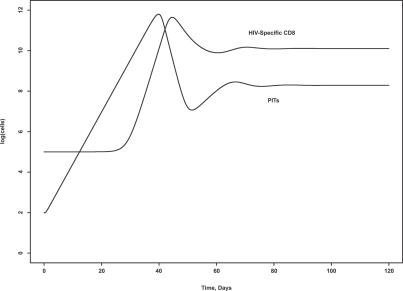
Whole-Body, Deterministic Model Suitable for HIV, Showing Infection and Immune Response; with R
0 = 4, progression time (IT to PIT), one day; and α = κ = 10−10